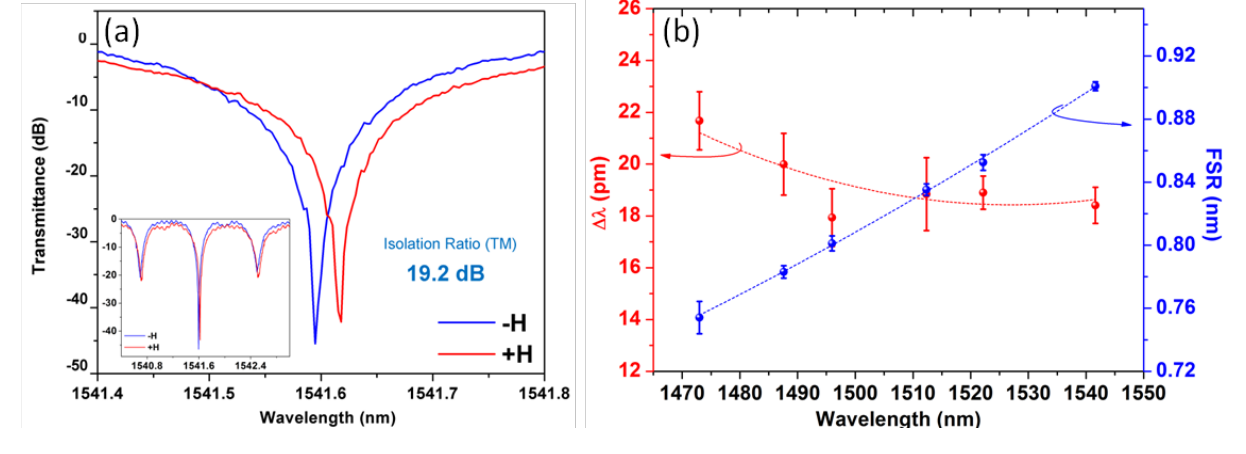
Figure 10. ( a ) TM-mode transmittance spectra as a function of the applied magnetic field at near critical coupling resonance; ( b ) Wavelength dependence of the nonreciprocal resonance peak shift and the FSR [105]. (Reprinted with permission from [105].